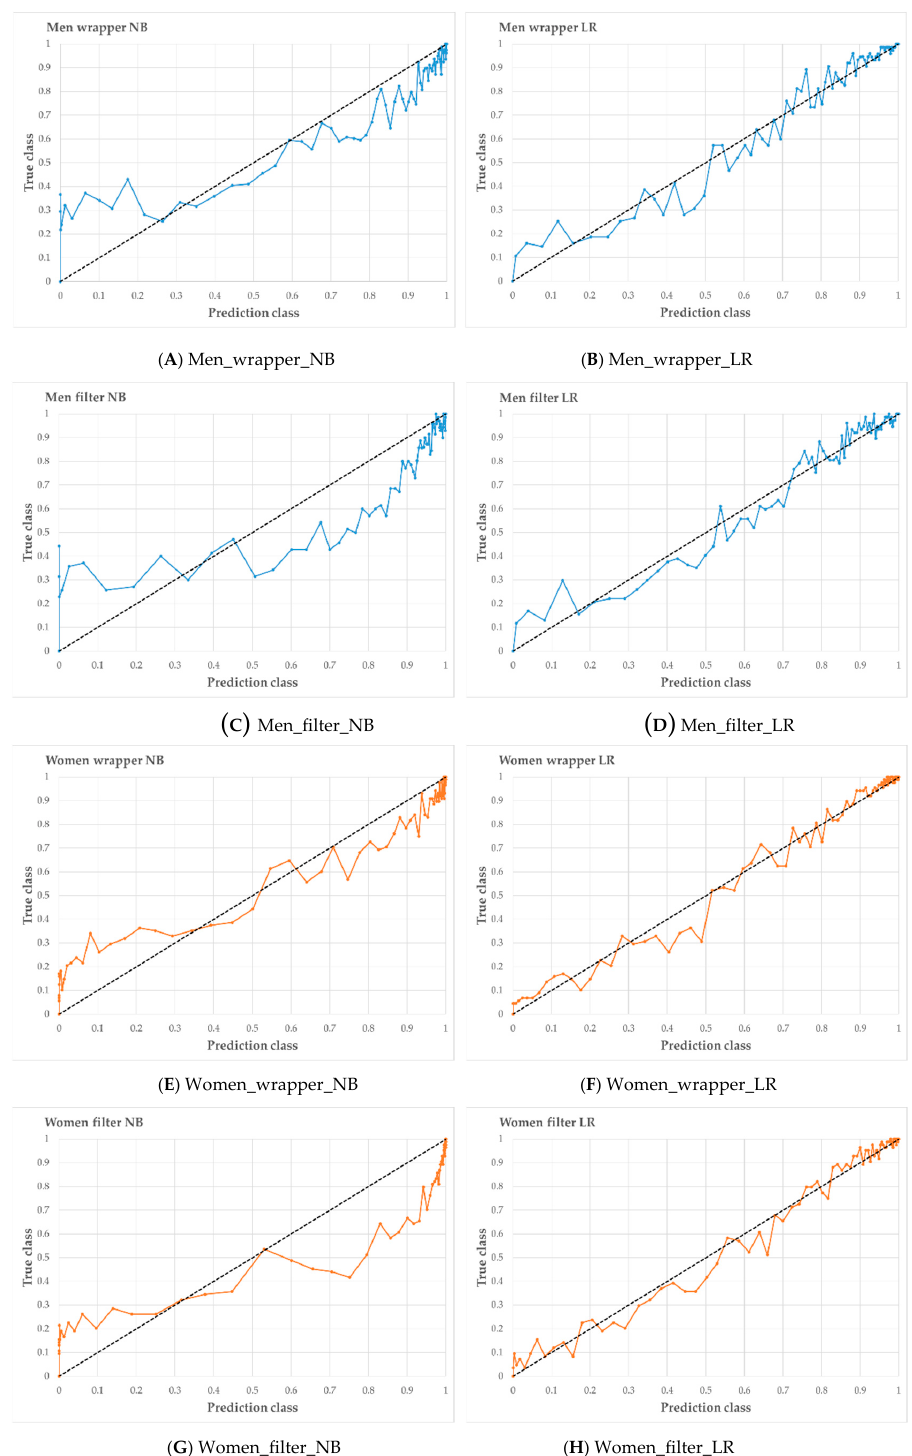
Figure 6. Calibration curve of four models in men ( A – D ) and women ( E – H ). When the line of the calibration plot is straight, the prediction model was presented the best